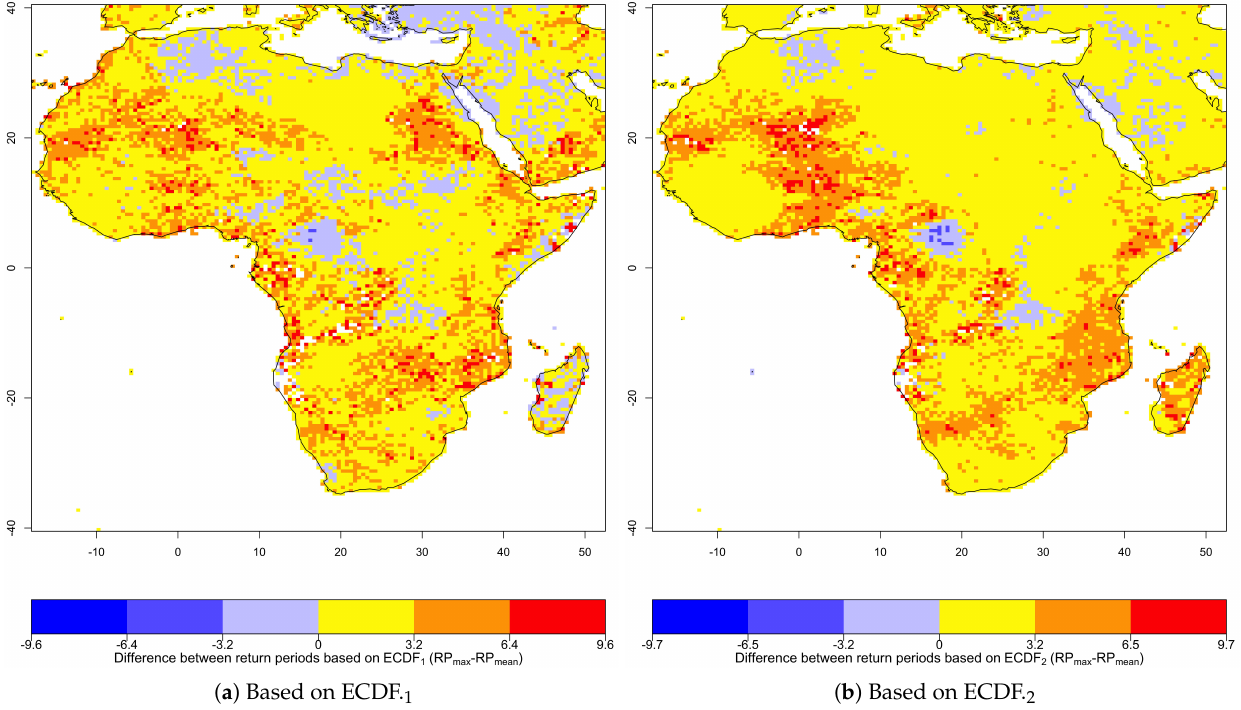
( a ) Based on ECDF. 1 Figure 14. Difference between return periods of extremes in annual maxima and annual means ( ˆ RP maxima on the same ECDF: ( a ) based on ECDF 1 and ( b ) based on ECDF 2